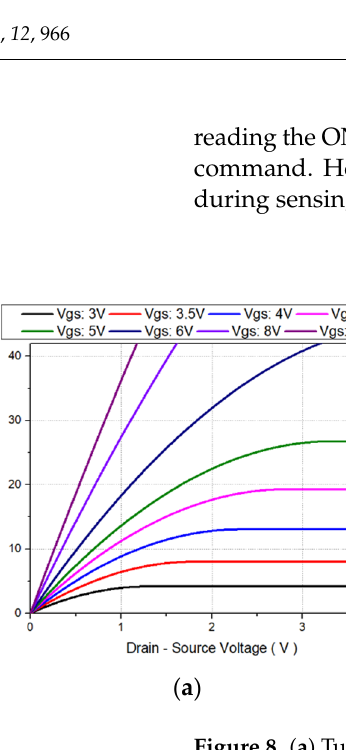
( b ) Figure 7. ( a ) A situation in which − / 2 DC V voltage is applied to the motor when the current flows in the positive direction and is in a dead-time condition ( b ) A situation in which / 2 DC V voltage is applied to the motor when the current flows in the negative direction and is in a dead-time con- dition . The disturbance voltage dead V applied to the motor by the dead time can be